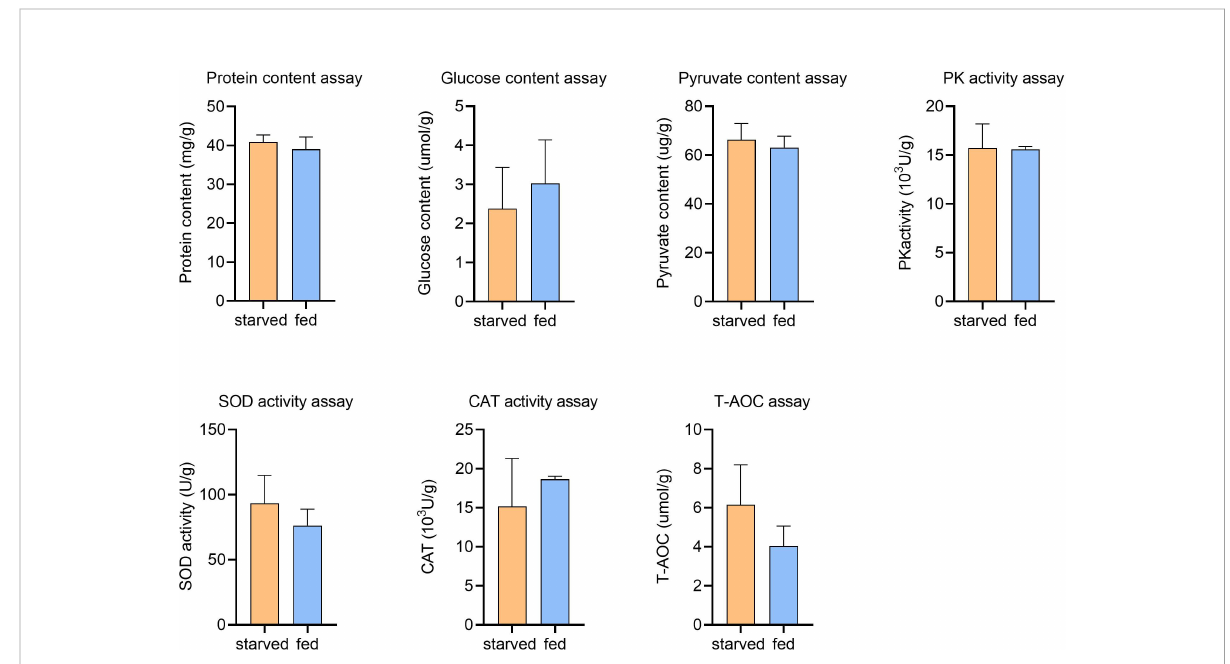
FIGURE 6 Physiological assays for starved and fed CoTS stomach tissue. Means ± S.E., n starved = 6, n fed =